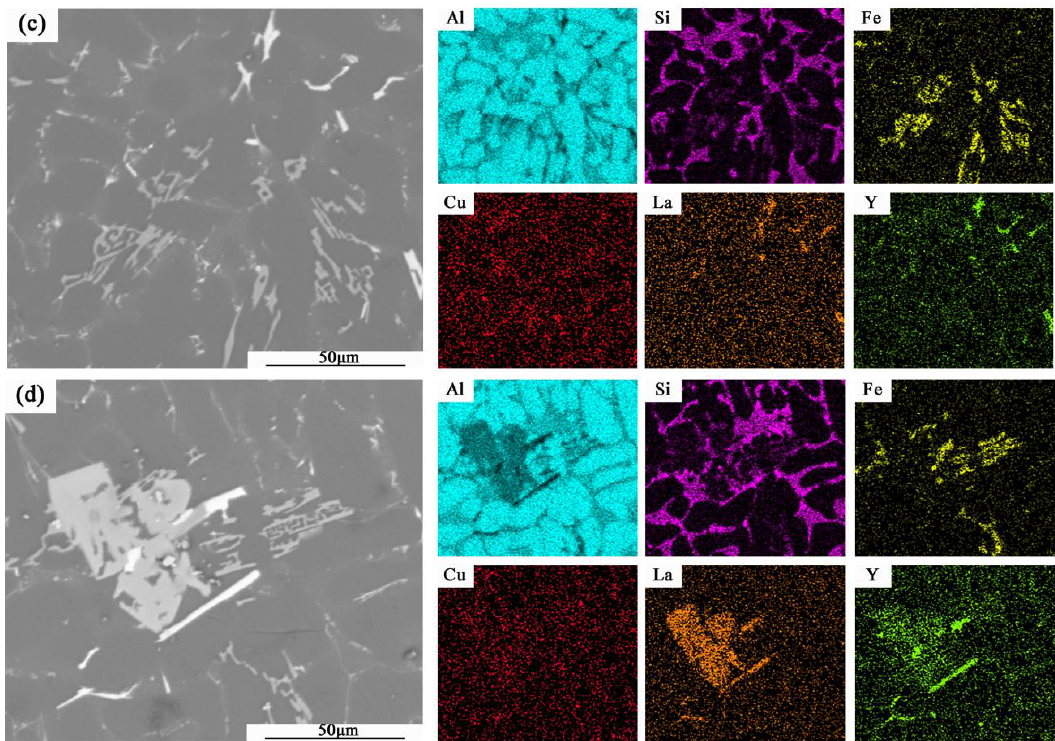
Figure 4. Scanning electron micrographs of cast A380 alloys with different (La+Y) additions: ( a ) matrix alloy; ( b ) 0.3 wt.%; ( c ) 0.6 wt.%; ( d ) 0.9 wt.%.